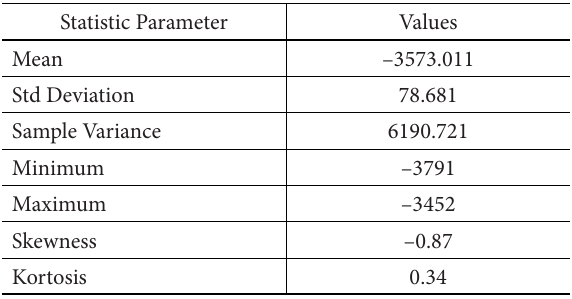
Table 1. Comparison of statistical parameters before and